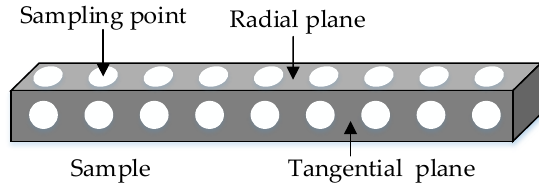
Figure 2. The spectral collection points of specimen.